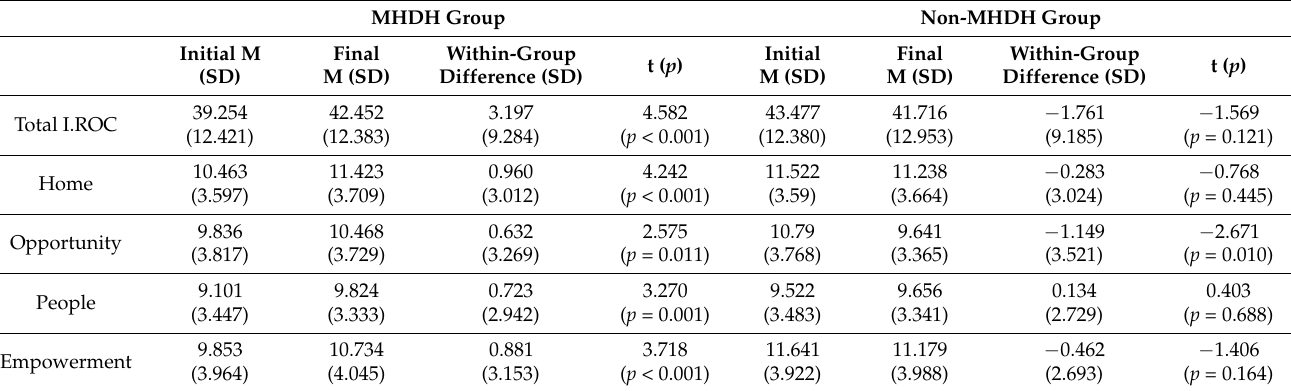
Table 2. Within-group differences.